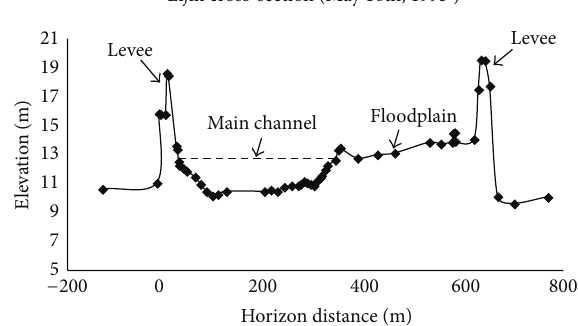
Figure 3: Typical cross-sectional profile at Lijin